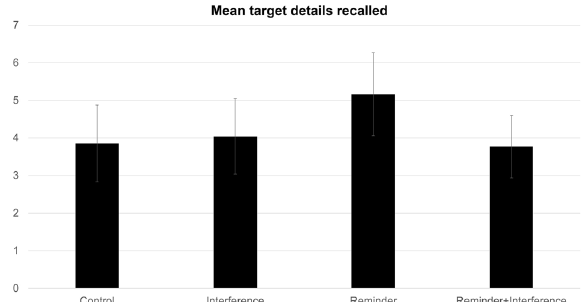
Fig. 4 Recall accuracy for each condition of Experiment 3, in mean number of correctly recalled details of 25 possible target details. Brackets represent 95% con fi dence intervals.